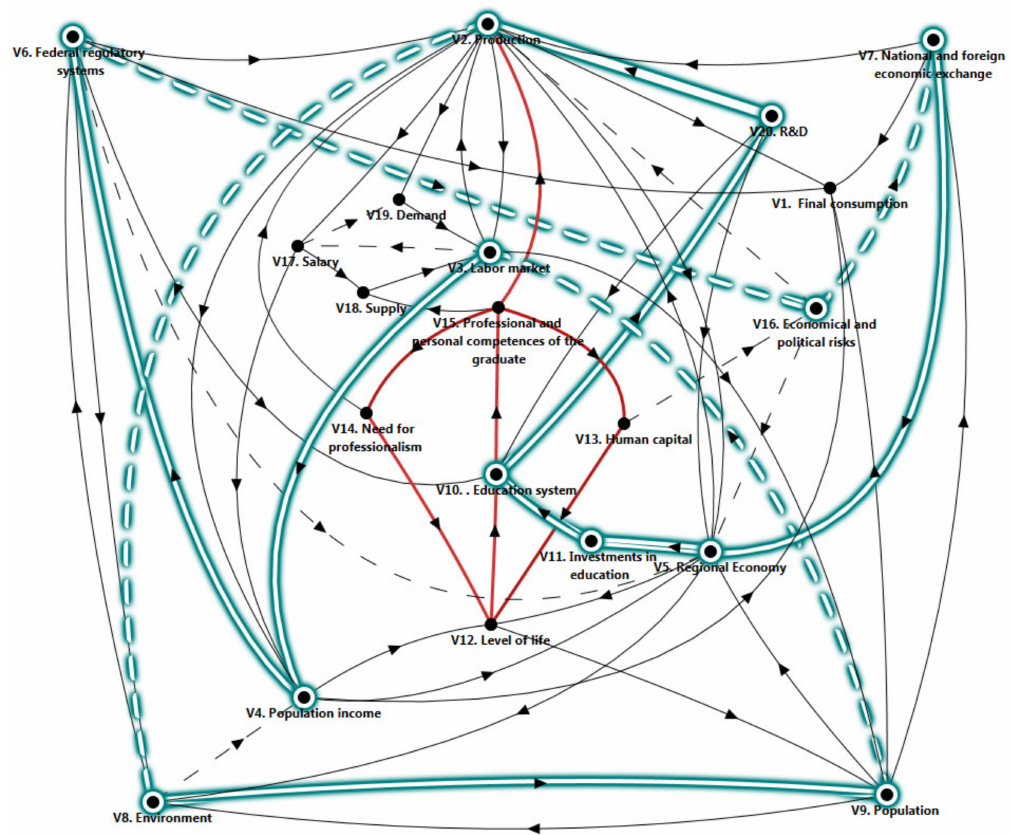
Figure 3. Highlighting (blue) the “positive” cycle of the regional system